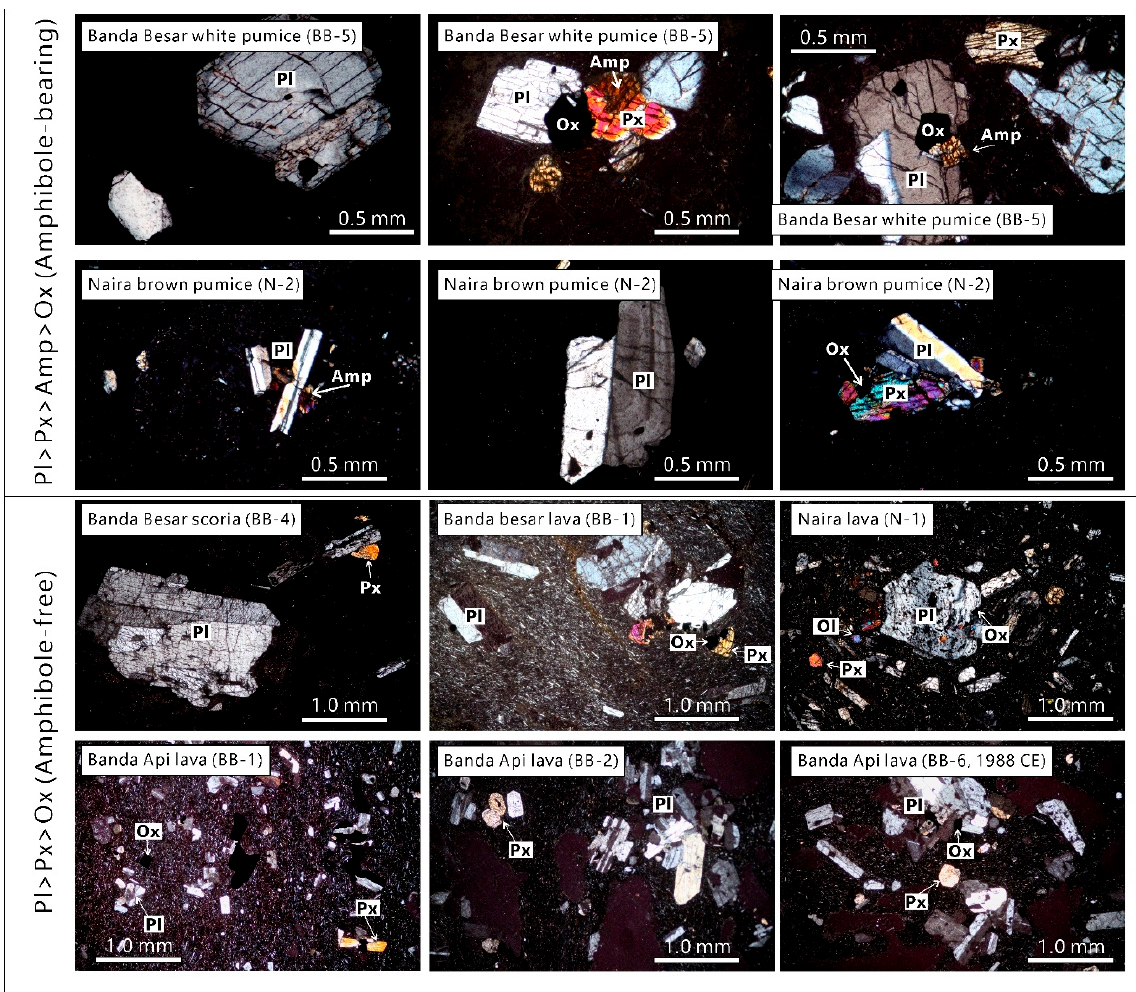
Figure 12. Petrographic images of pumice, scoria, and lava from Banda Besar, Naira, and Banda Api eruptive units. Here, Pl, Px, Amp, and Ox correspond to plagioclase, pyroxene, amphibole, and oxides, respectively. Pumices (from Banda Besar and Naira) are characterized by the presence of amphibole (Pl > Px > Amp > Ox), whereas scoria and lavas are amphibole-free. Phenocrysts in Naira pumice are relatively smaller than those of Banda Besar, as is the pheno-crystallinity. Scoria and lava (from Banda Besar, Naira, and Banda Api) typically have larger and more abundant phenocrysts than pumice. Note the scale difference between the pumice and scoria-lava images.